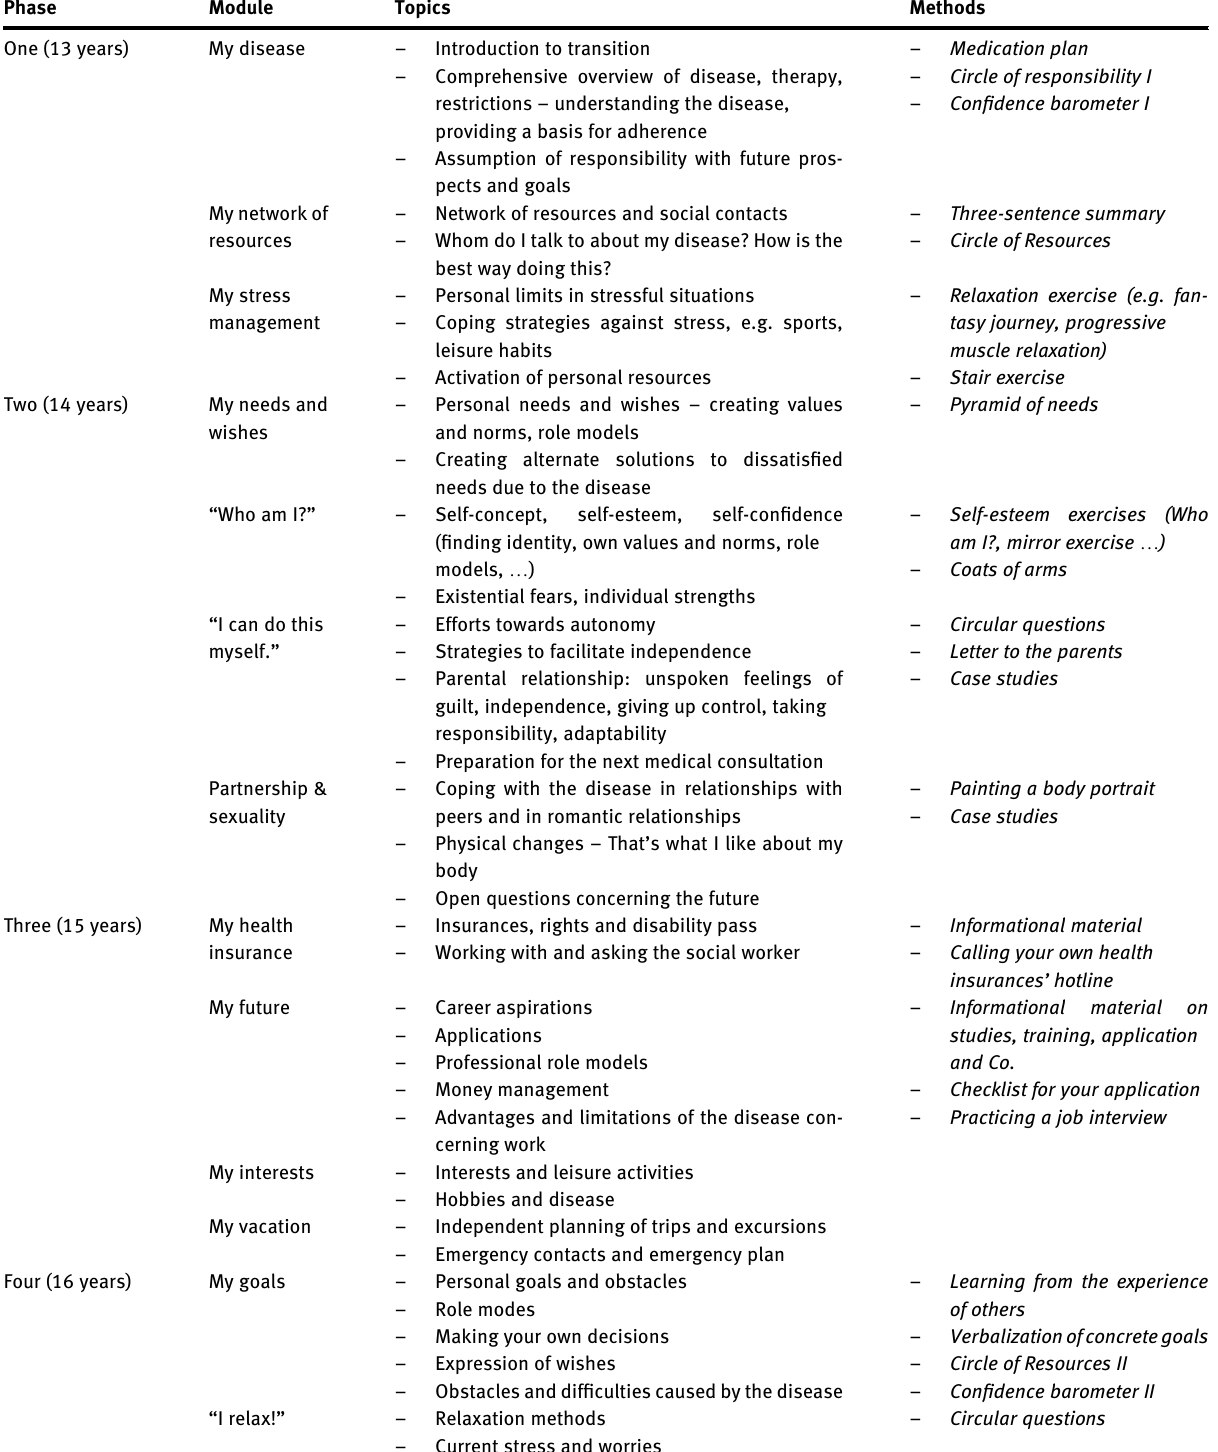
Table  : The  modules of the transition program “ TraiN ” and the related topics that are being worked on. Phase